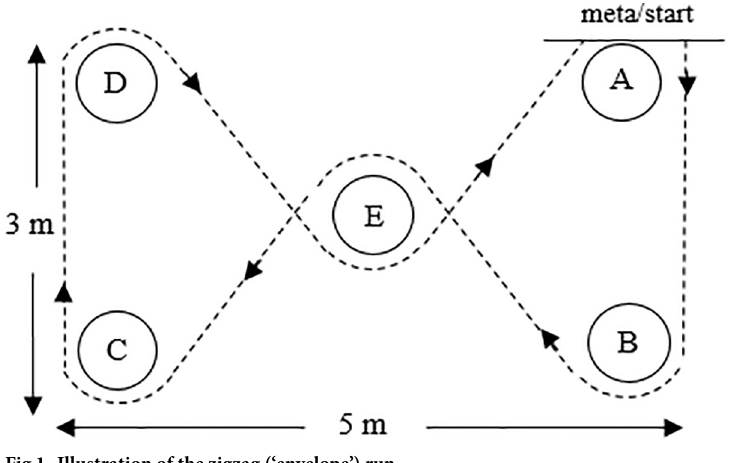
Fig 1. Illustration of the zigzag (‘envelope’)